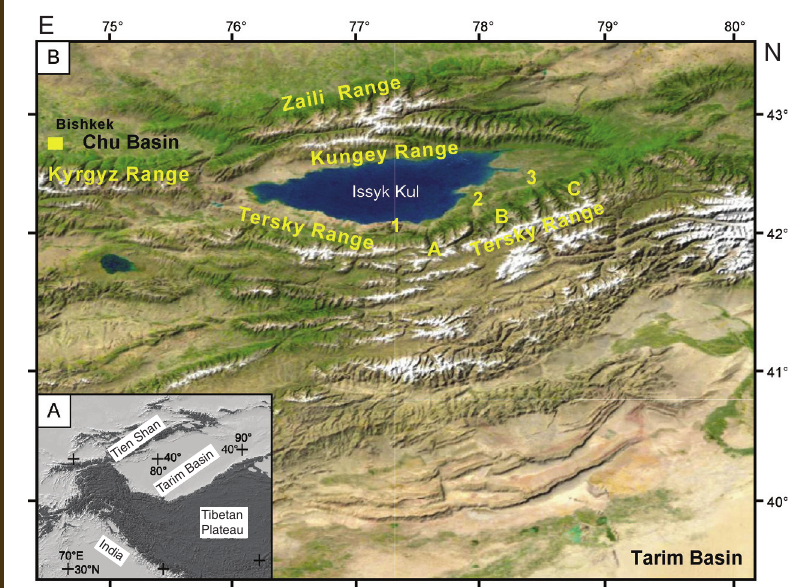
Figure 1. Topographic map of the Tien Shan showing the location of Issyk Kul and range-and-basin nature of the belt.